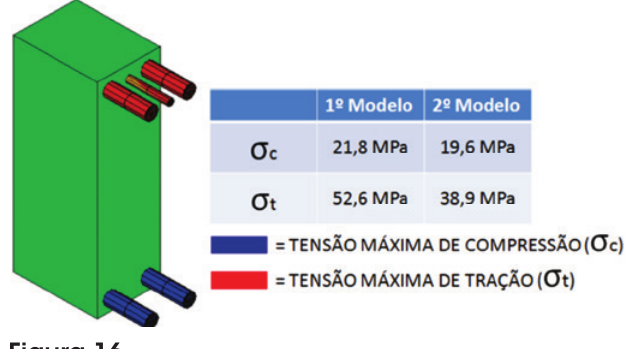
Figura 16 Tensões no aço na seção de momento máximo